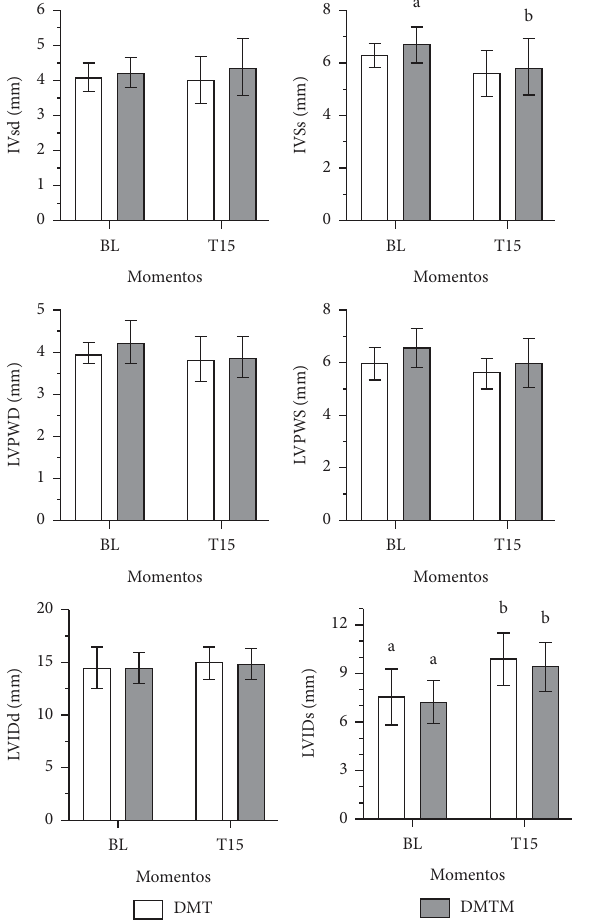
Figure 4: Values for shortening fraction (FS%), ejection fraction by Simpson (FE), heart rate (HR), end-systolic volume (ESV), ejection volume by Simpson (VE), and cardiac output by Simpson (CO), in 18 cats sedated with the association of dexmedetomidine (7.5ug/ kg) and methadone (0.3mg/kg) (DMT, n � 9) or dexmedetomidine (5ug/kg), methadone (0 .3 mg/kg), and midazolam (0.3mg/KG) (DMTM, n � 9), both by the intramuscular route. Values are presented as mean ± standard deviation. a, b: Diferent lowercase letters indicate a signifcant diference between moments within the same group according to the Tukey test ( p < 0 .